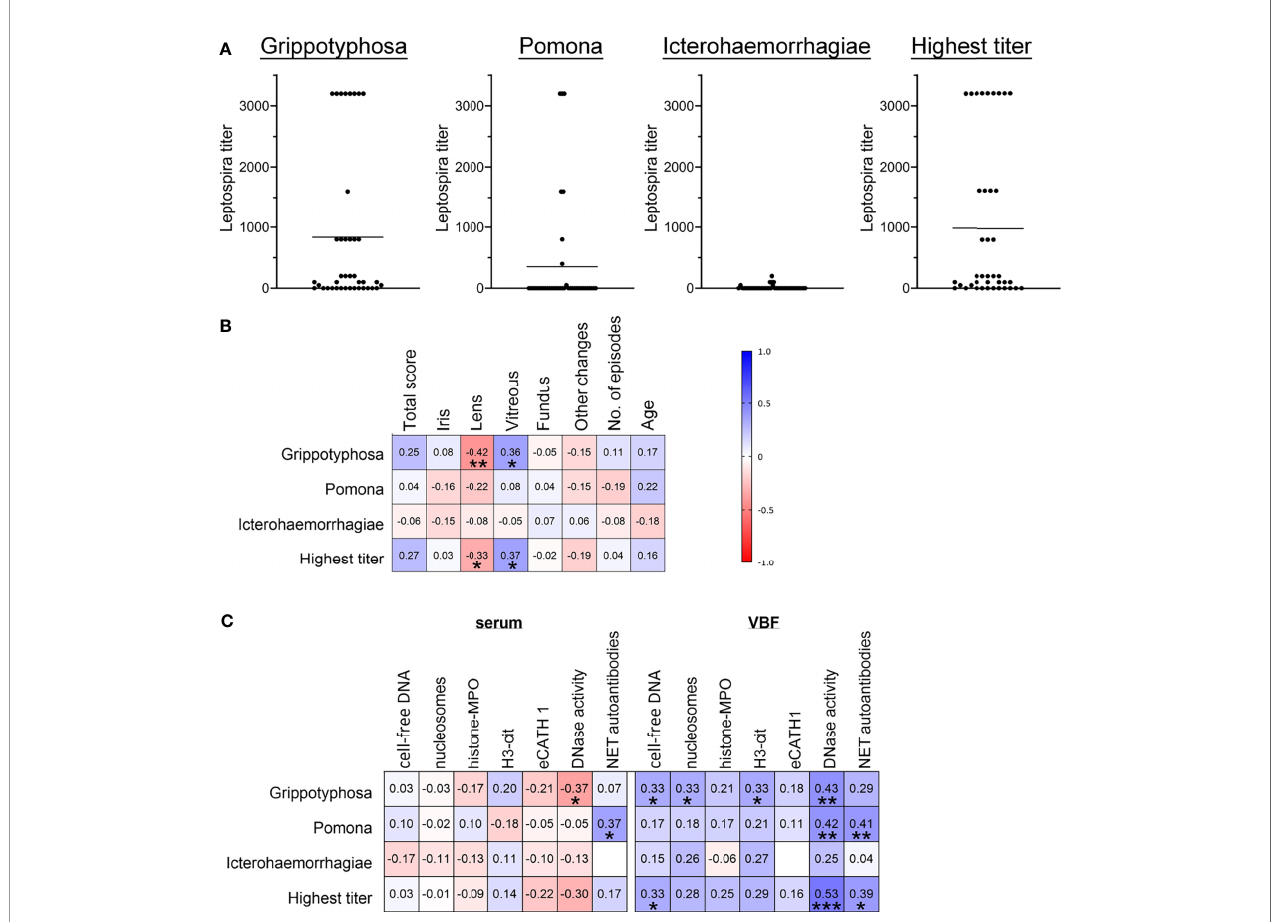
FIGURE 7 | Correlations between severity of ERU, occurrence of NET markers and Leptospira . Correlations between ERU scores, Leptospira spp. titers and NET markers in sera and vitreous body fl uids (VBF) of 40 horses with equine recurrent uveitis (ERU) were tested. Part (A) shows the distribution of the three Leptospira serovars Grippotyphosa, Pomona and Icterohaemorrhagiae, and of the highest titer value per sample. Individual data points are given along with the mean value for each graph. In (B) , the resulting correlation matrix between ERU severity data and Leptospira titers is depicted. A signi fi cant correlation was found between the vitreous score and serovar Grippotyphosa. Correlations between NET markers and Leptospira titers are displayed in (C) . Signi fi cant correlations between Leptospira spp. serovars and various NET markers in serum (DNase I activity, NET autoantibodies) and in VBF (free DNA, nucleosomes, H3-cit, DNase I activity, NET autoantibodies) were observed. A two-tailed Pearson correlation was performed for (B, C) . Pearson ’ s r values are presented, and p values are shown if signi fi cant. p values of * p < 0.05, ** p < 0.01 and *** p < 0.001 were considered signi fi